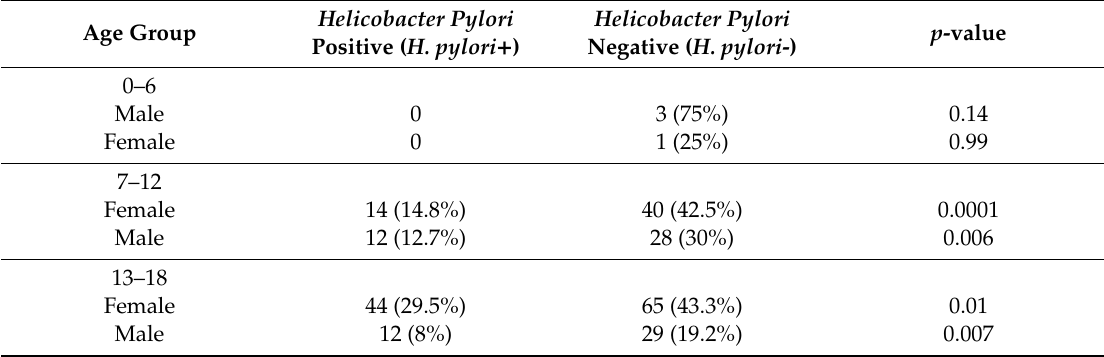
Table 2. Comparison between the H. pylori positive group and H. pylori negative group according to age groups.